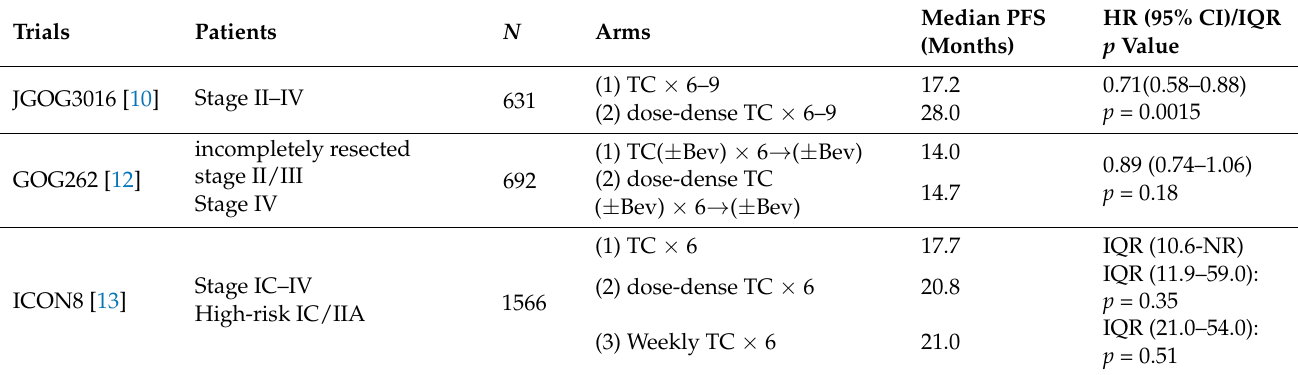
Table 2. Clinical trials of primary therapy for ovarian cancer.